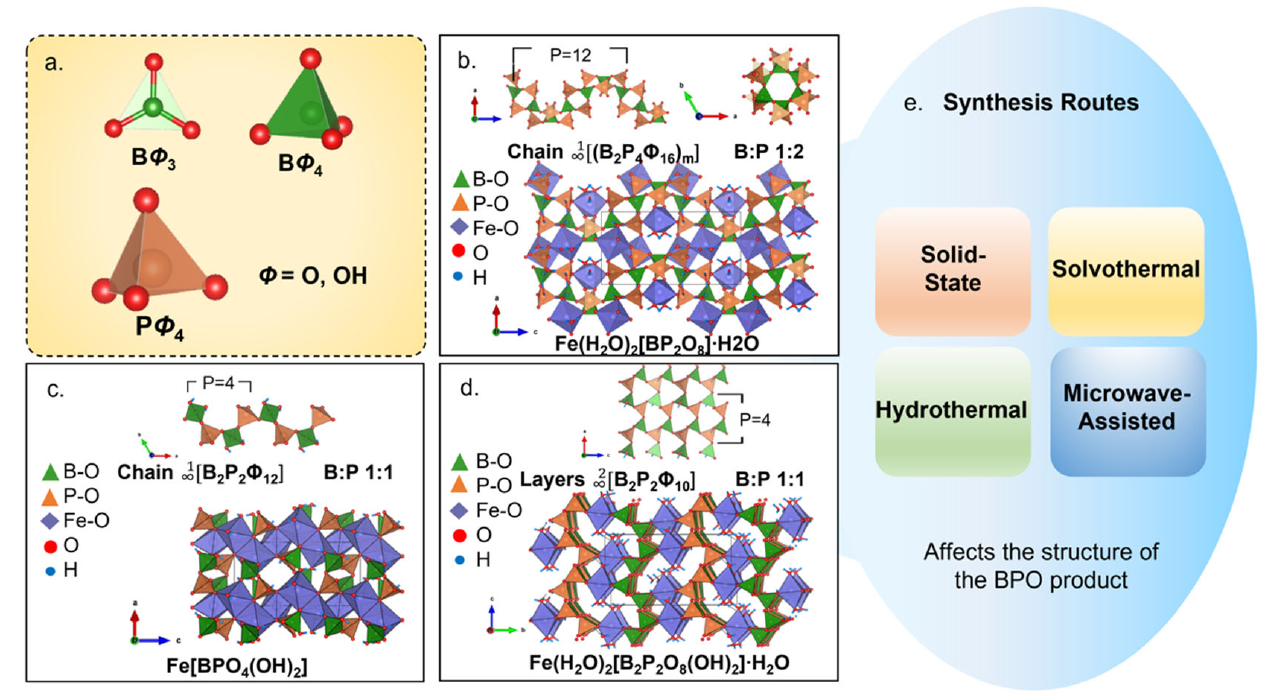
Figure 9. ( a ) The construction of BPO structures consists of at least one borate unit, three ‐ or four ‐ coordinated, B Φ 4 and one phosphate unit, P Φ 4 . ( b ) Fe(H 2 O) 2 [BP 2 O 8 ] ∙ H 2 O (bottom) [131] with its BPO 1D helical chain FBU structure (top). ( c ) Fe[BPO 4 (OH) 2 ] (bottom) [132] with its BPO 1D chain FBU structure (top). ( d ) Fe(H 2 O) 2 [B 2 P 2 (OH) 2 ] ∙ H 2 O (bottom) [133] with its BPO 2D 6 3 net ‐ topology FBU structure (top) (FBUs were adapted with permission from [130]. Copyright 2007, WILEY ‐ VCH Ver ‐ lag GmbH & Co. KGaA, Weinheim). ( e ) Synthesis routes of BPO compounds.